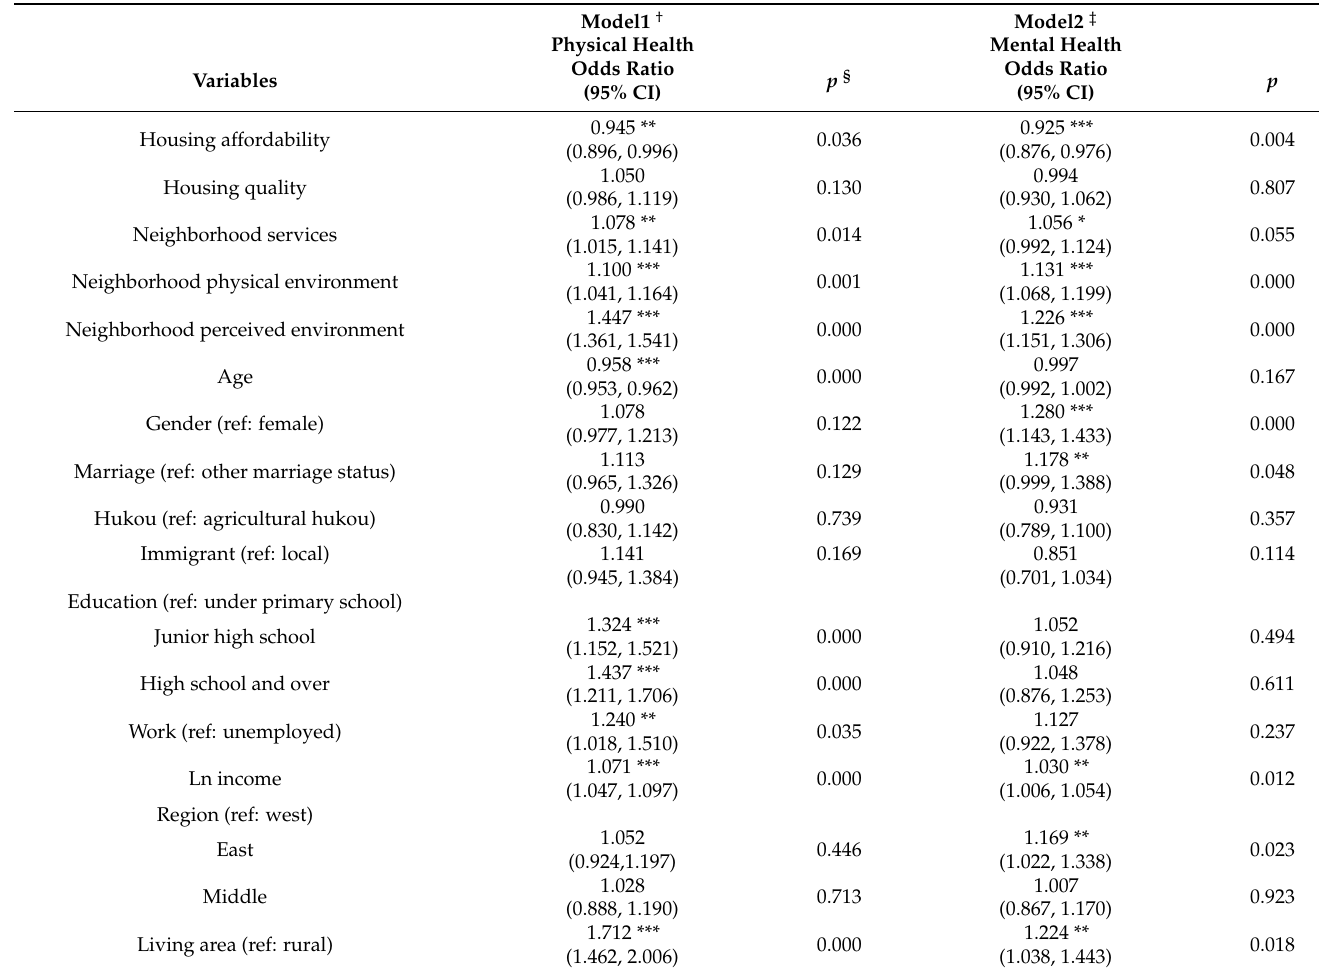
Table 5. Ordered logistic regression results of the associations between built environment and health status. Model1 † Physical